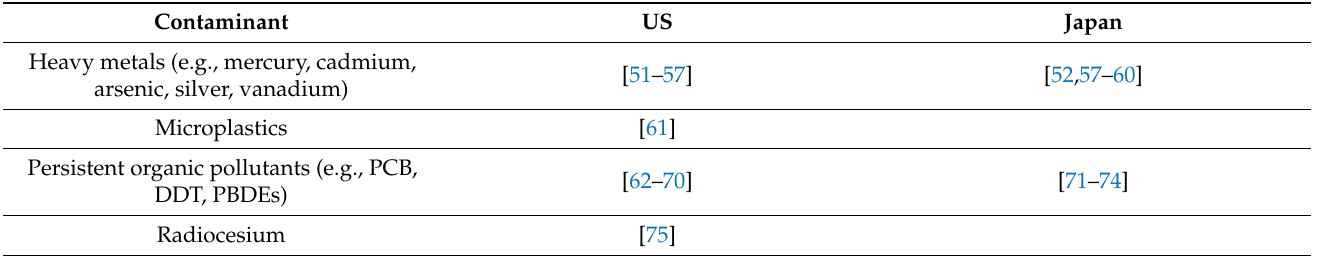
Table 1. A summary of the identified literature on contaminants in